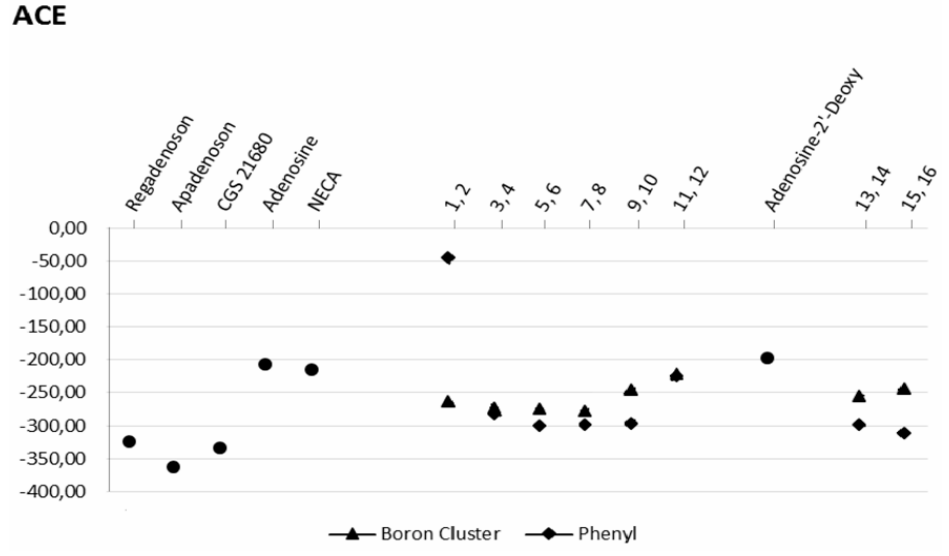
Figure 6. Desolvation energy (ACE) for the A2A protein-ligand interactions. reference molecules (apadenoson, CGS 21680, adenosine, 2 ′ -deoxyadenosine, NECA and SCH 58261; molecules bearing a boron cluster ( 1 , 3 , 5 , 7 , 9 , 11 , 13 , 15 ); ligands with a phenyl group ( 2 , 4 , 6 , 8 , 10 , 12 , 14 , 16 ) .